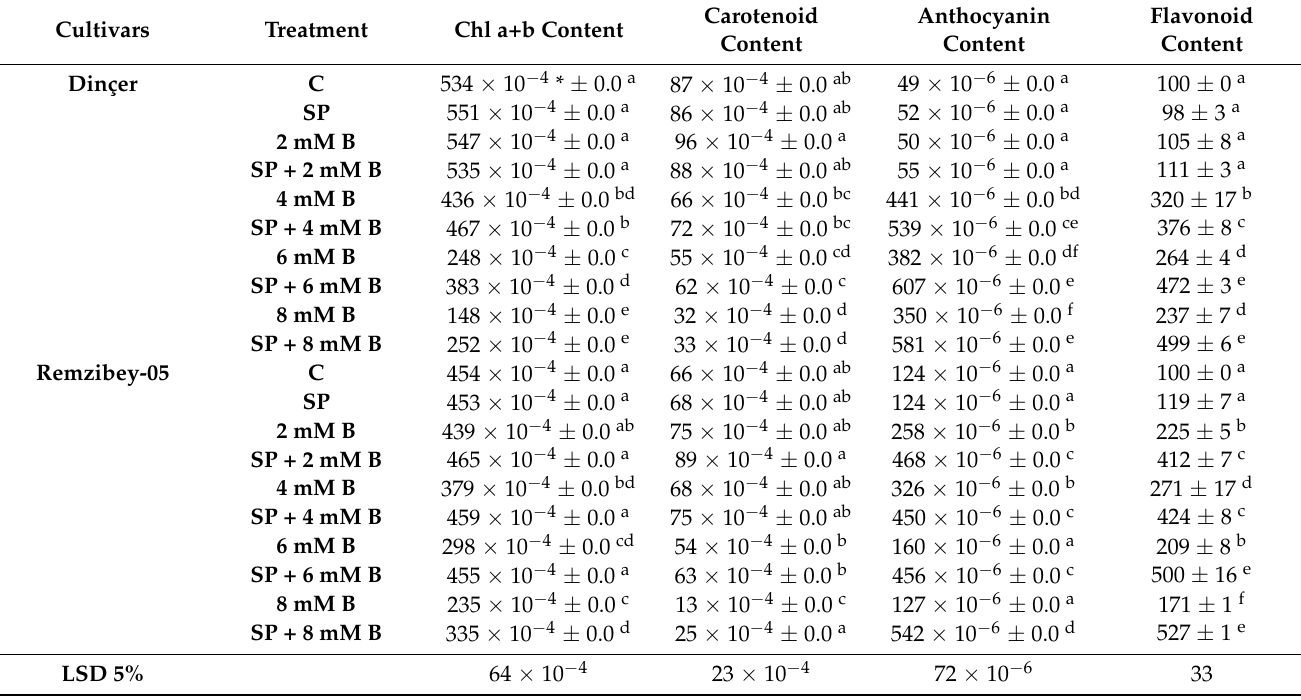
* Each value represents the mean of 6 replicates ( n = 6) and its standard error ( ± SE). Different letters indicate significant difference between treatments and cultivars at p < 0.05 according to the LSD